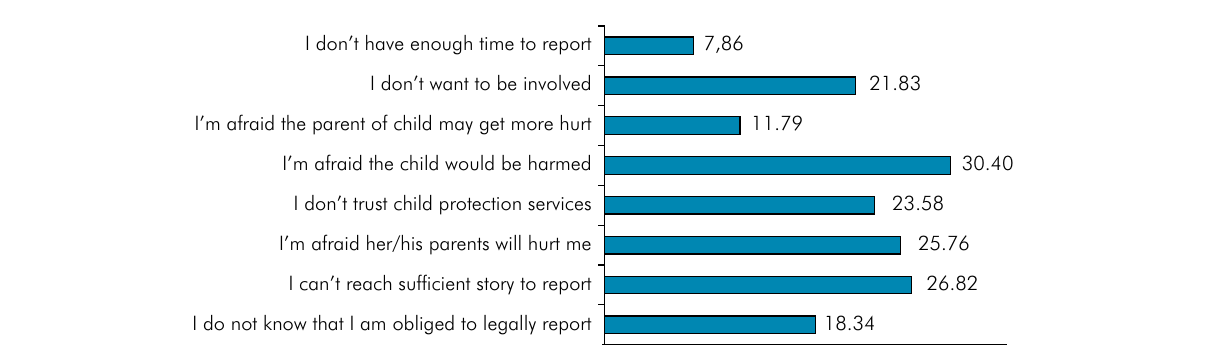
Figure. Reasons for not reporting when participants suspect child abuse and neglect (multiple choice was